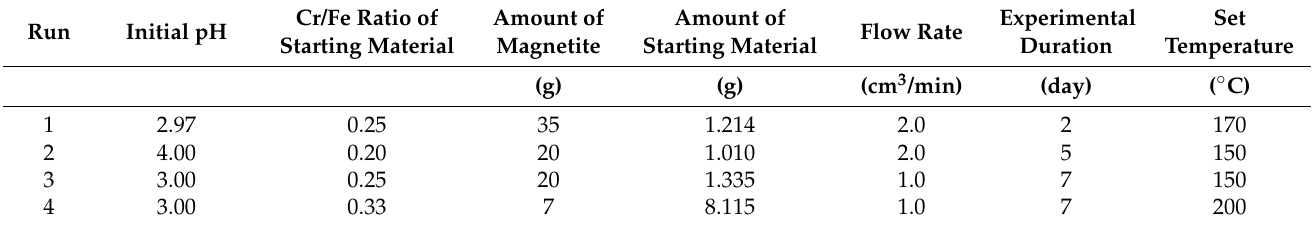
Table 1. Experimental conditions for hydrothermal chromian spinel formation by hydrothermal alteration of Fe-Cr hydroxides.